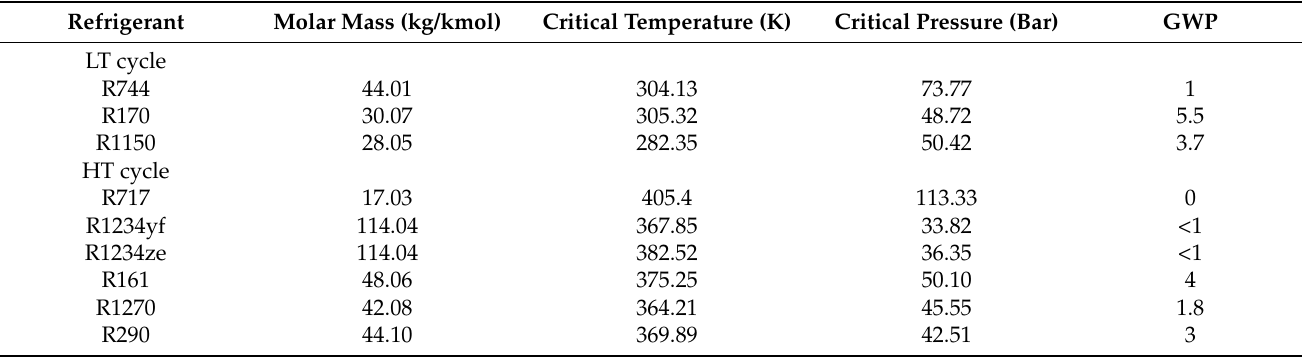
Table 1. Properties of refrigerants selected for this study